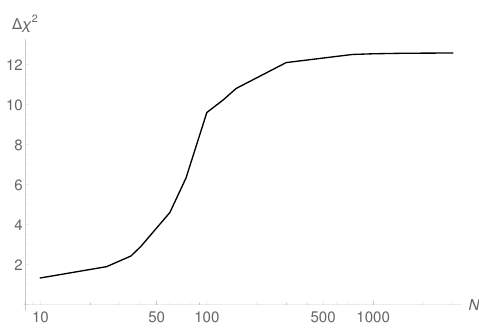
Figure 3 . (cid:1) (cid:31) 2 as a function of the number of energy bins considered in the 1.5{8.5 MeV region. Only the uncertainty on (cid:1) m 2 is taken into 32